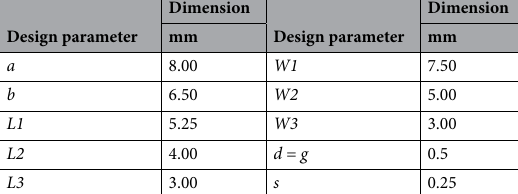
Table 1. Design parameters of metamaterial unit cells.